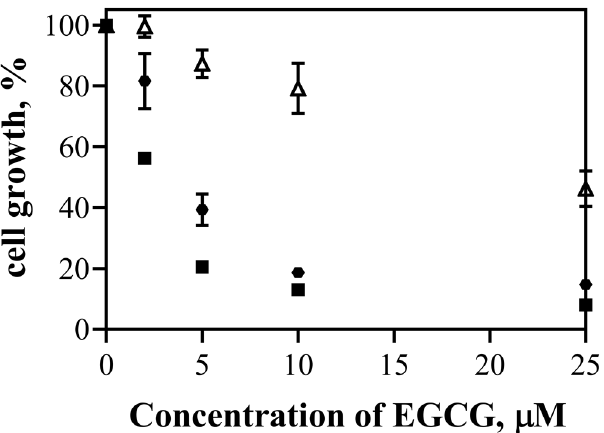
Figure 7. Effect of free EGCG ( Δ ), EGCG-AuChNPs ( ◼ ) and EGCG-CysAuNPs ( ) on the growth of pancreatic cancer (BxPC3 cells).